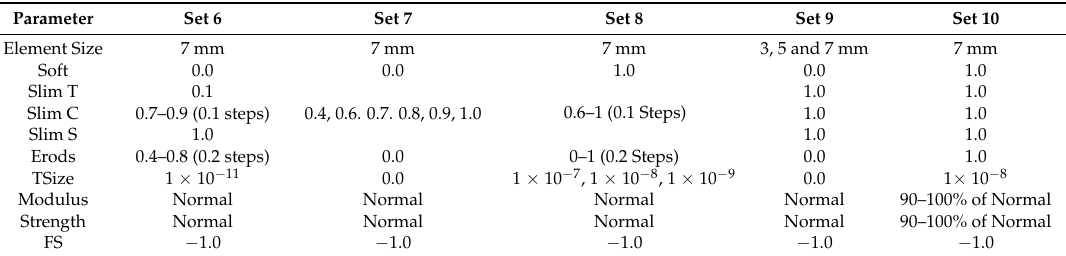
Table 8. Parameter used in different model runs (Part